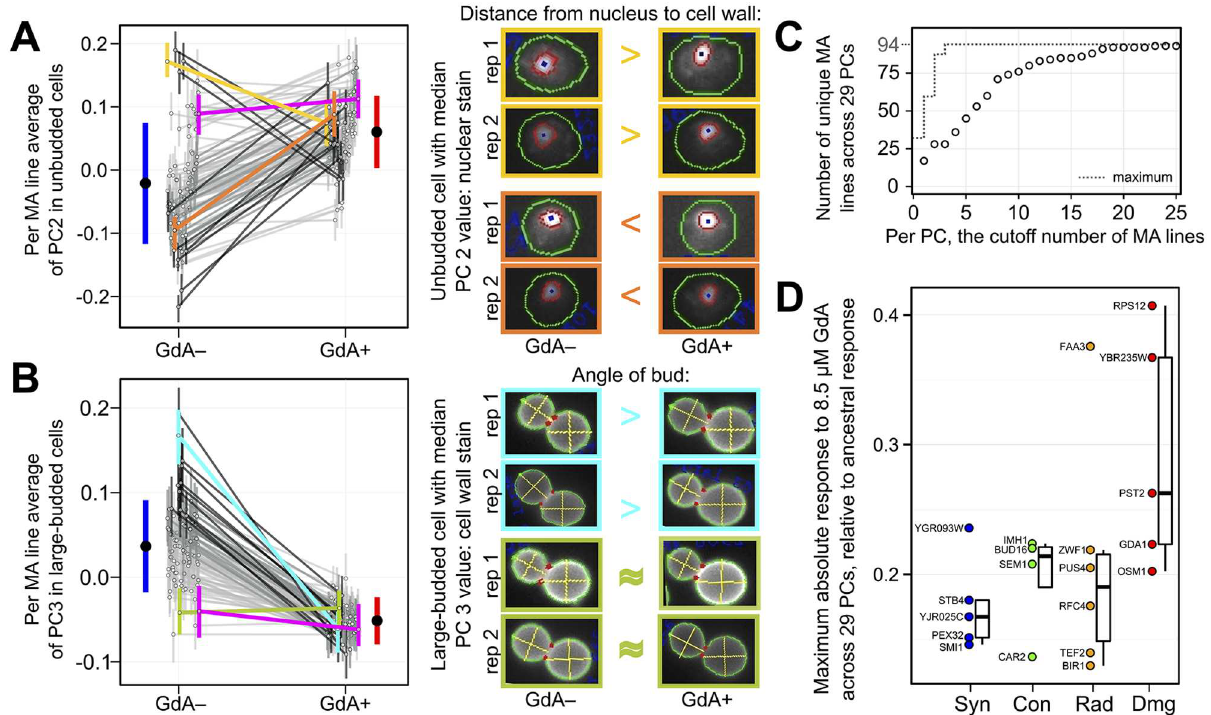
Fig 3. Many MA lines possess spontaneous mutations with GdA-dependent effects on morphology. (A–B) Two example phenotypesfor which some MA lines have unique responses to GdA (for other phenotypes, see S2 Fig). Each open circle and its associated vertical bar represents the average morphology of an individualMA line in either the GdA − or GdA+ condition, +/– 1 standard deviation. Lines connect open circles representing the same MA line; the darkness of each black line is proportional to how much a given MA line’s response to GdA differs from the ancestor’s. Colored lines: magenta = MA ancestor; yellow = MA line #2; orange = MA line #30; cyan = MA line #42; olive = MA line #137. Micrographs(with cell images adjusted for uniform size and orientation) reflect how morphological traits that contribute strongly to each PC respond to GdA in selected strains. The cells shown from each replicate (“rep 1” or “rep 2”) possess the value closest to the median for a given PC in the given strain and treatment. The trait that contributes most strongly to each PC is listed above the cell images (and in S1 Table); the > , < , or (cid:25) symbols indicate how this trait differs in GdA − versus GdA+ cells. Each solid black circle and its associated blue or red vertical bar reports the average phenotype+/– 1 standard deviationacross all MA lines in GdA − or GdA+. (C) The MA lines with the most divergent responsesto GdA, relative to the ancestral response, differ for different PCs (see also S3 Fig and S2 Table). This cumulative distribution describesthe number of unique MA lines represented among the top 1 through 25 most-divergently respondingMA lines for each PC (open circles). The dotted line shows the maximum possiblevalue. (D) MA lines possessing coding mutations predicted to have severe effects on protein function tend to have greater responsesto GdA relative to the ancestral response (see also S2 Table). Open circles represent 20 of the 94 MA lines that each possess only a singlecoding mutation. The mutated gene is listed next to the circle. Vertical axis represents the maximum absolute value of the differencein MA line versus ancestral response to GdA across all 29 PCs. Boxplots represent the distribution of these maximum absolute differences for MA lines with either a single synonymous(“Syn”), conservative (“Con”), radical (“Rad”), or damaging(“Dmg”) mutation, displayingthe median(center line), interquartile range (IQR) (upper and lower hinges), and highest value within 1.5 × IQR